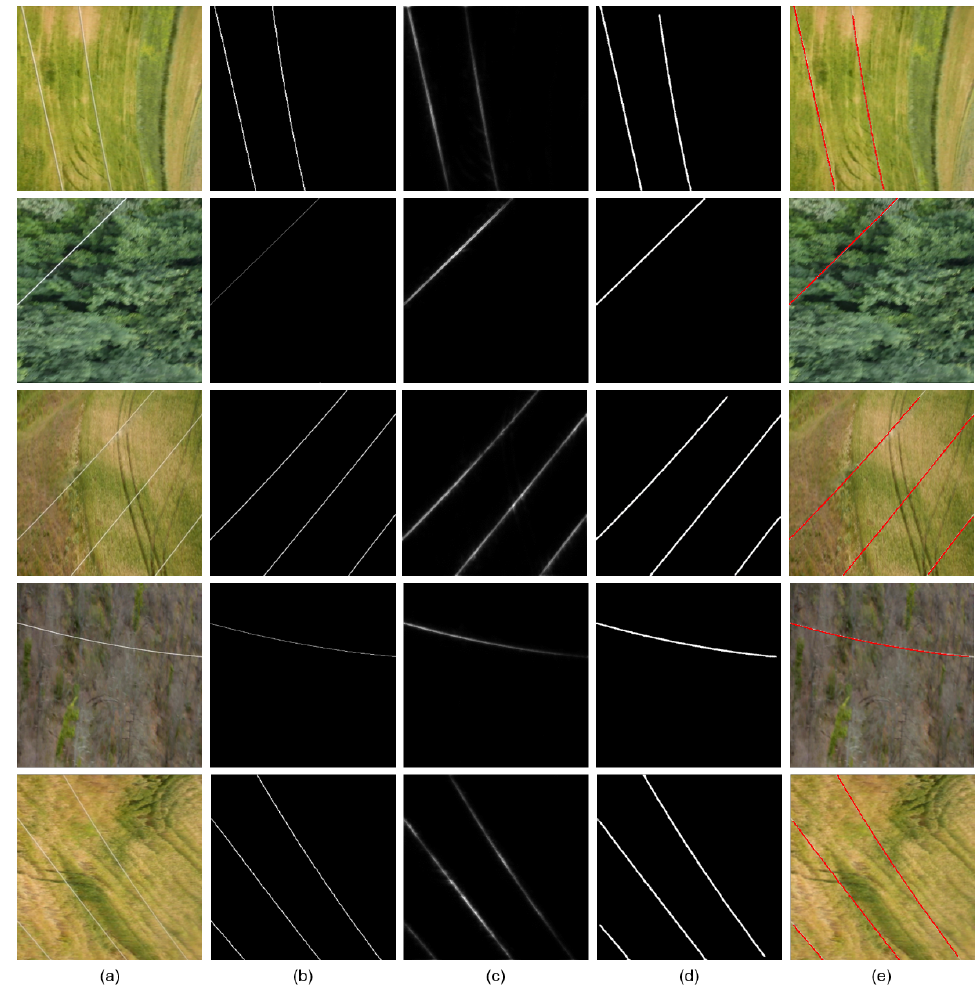
Figure 8. Results of transmission line detection using our proposed method. ( a ) Original image. ( b ) Ground truth. ( c ) ALM. ( d ) Refined ALM. ( e ) Overlaid image with the refined